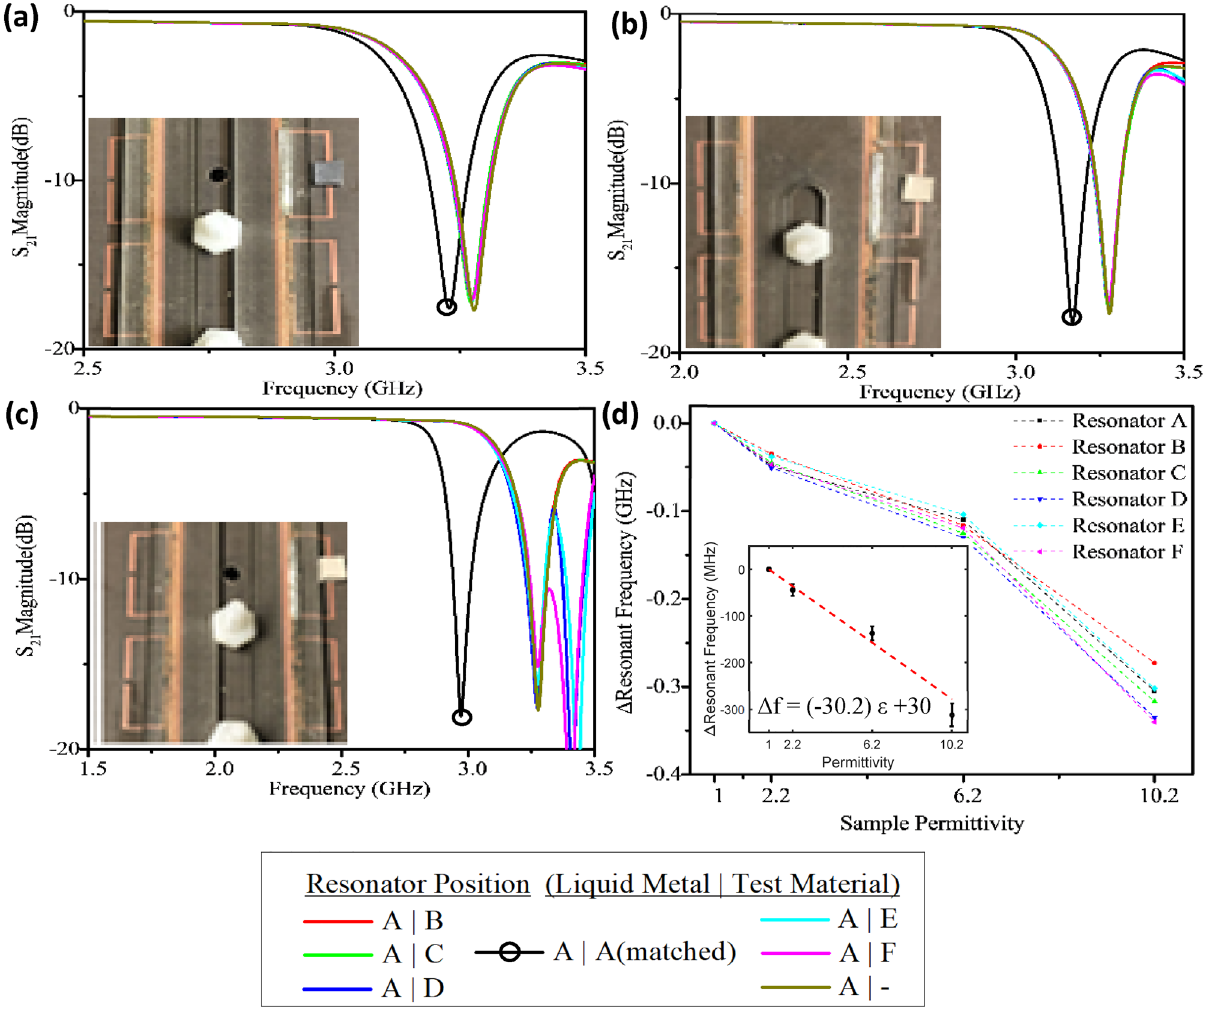
Figure 6. The fabricated sensor’s frequency response when resonator A is selected by the liquid metal (inset photos). Test materials with permittivity of 2.2 ( a ), 6.2 ( b ), and 10.2 ( c ) induced a measured frequency shift when placed on the selected resonator (circled black). The recorded sensitivity curves are shown for each individual resonator ( d ) and error bars of the inset generated by performing each test three times.